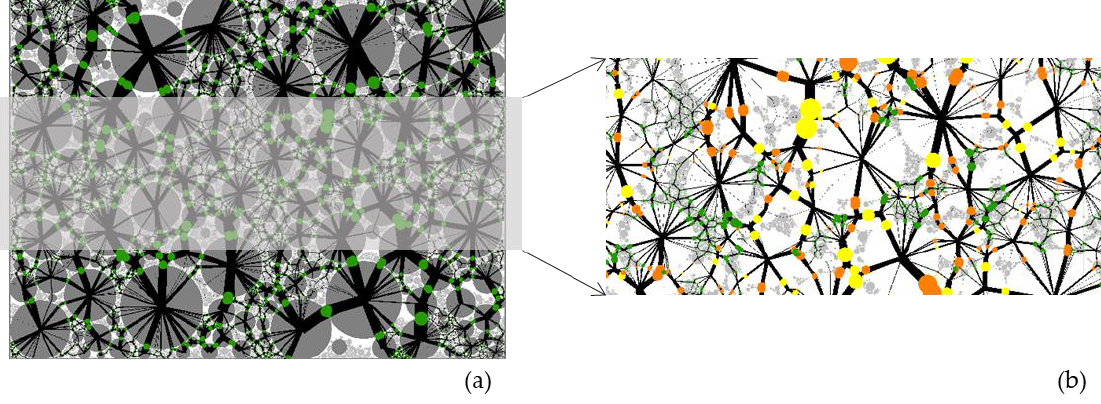
Figure 2. Distribution of contact points and contact force at larger ( a ) and smaller ( b ) scales.